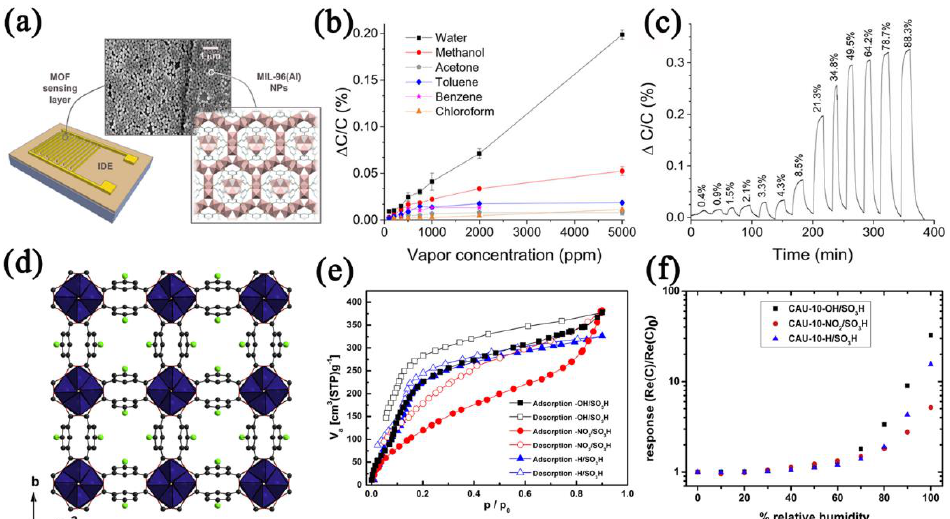
Figure 10. ( a ) MIL − 96(Al) structure and SEM image of MIL − 96(Al) LB film on the IDE electrode. ( b ) Selectivity of MIL − 96(Al) − based sensor to water vapor and other vapors. ( c ) Response curve of MIL − 96(Al) − based sensor to humidity in the range of 0.4 – 88.3% RH. Reproduced with permission from Ref. [54]. Copyright 2020, American Chemical Society. ( d ) Crystal structure of the CAU − 10 − X with AlO 6 octahedra helices (blue), isophthalate linkers (black), and position of the functional groups (green). ( e ) Water sorption isotherms of CAU − 10 − X at 298 K. ( f ) Responses of CAU − 10 − X − based sensors to humidity in the range of 0 – 100% RH. Reproduced with permission from Ref. [98]. Copyright 2022, Elsevier.